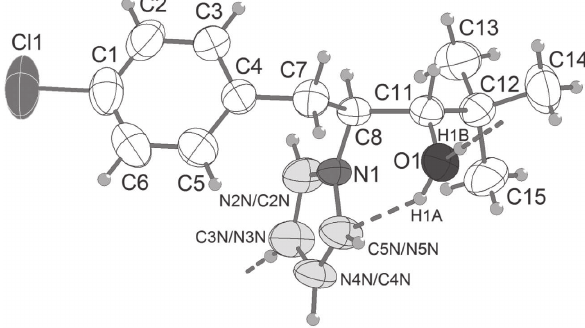
Table 1: Data collection and handling.